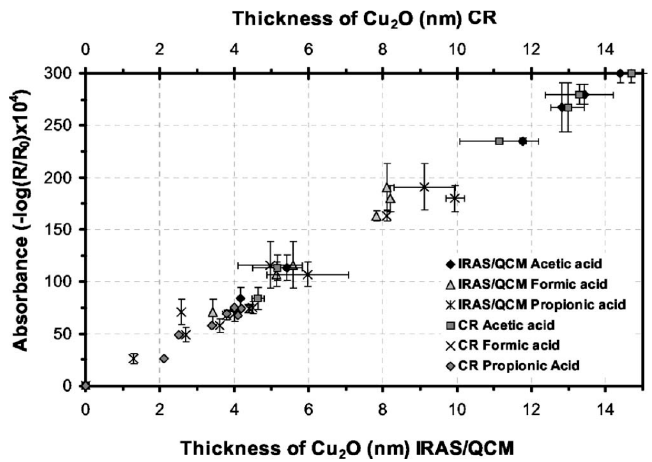
Figure 2. A linear relation between the results obtained from infrared reflection/absorption spectroscopy (IRRAS), quartz crystal microbalance (QCM), and cathodic reduction for the formation of Cu 2 O during exposure of a copper surface to 90% RH and 120 ppb carboxylic acids. Reproduced by permission of [35], The Electrochemical Society. Copyright 2007.